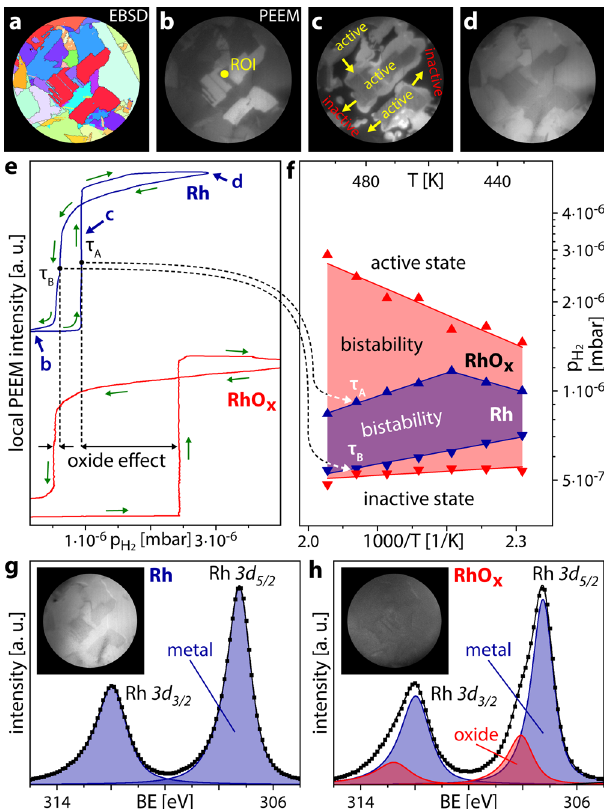
Fig. 3 Imaging catalytic H 2 oxidation on metallic and oxidised Rh. a EBSD map of the chosen Rh sample region (diameter 550 µ m, cf. Fig. 2a); b the same region imaged by PEEM (oxygen-covered metallic Rh surface), the contrast re fl ects the work function differences between different Rh(hkl) domains; c in situ PEEM image of an ongoing kinetic transition during H 2 oxidation, arrows show directions of propagating reaction fronts, bright areas correspond to the catalytically active surface; d PEEM image of the catalytically active steady-state resulting from the transition depicted in c ; e hysteresis curves registered by processing the local PEEM intensity of the ROI shown in b during cyclewise variation of the H 2 /O 2 pressure ratio from 0.1 to 6.5 at constant O 2 pressure of 7.7 × 10 − 7 mbar and temperature of 483 K. The upper and lower hysteresis curves correspond to the metallic and oxidised Rh surface, respectively; f kinetic phase diagrams for H 2 oxidation on the metallic (shaded blue) and oxidised (shaded red) Rh surface; g , h Rh 3d XPS spectra obtained by lab-XPS (excitation energy 1253.6 eV), for the metallic and oxidised Rh surface, respectively. Squares: measured values; solid lines: sum of the deconvoluted components. The insets show corresponding PEEM